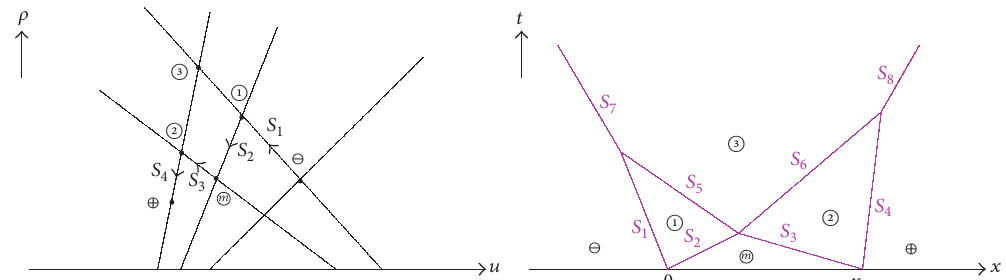
Figure 3: The interaction between 𝑆 + 𝑆 and 𝑆 + 𝑆 is displayed when (𝑢 + , 𝜌 + ) ∈ 𝑉 1